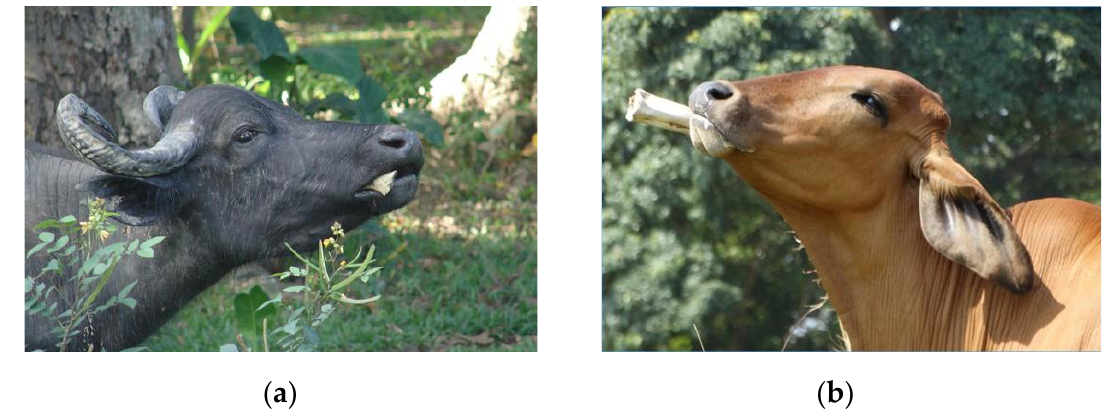
Figure 2. Clinically P-deficient buffalo ( a ) and cow ( b ) performing osteophagia [11,23].